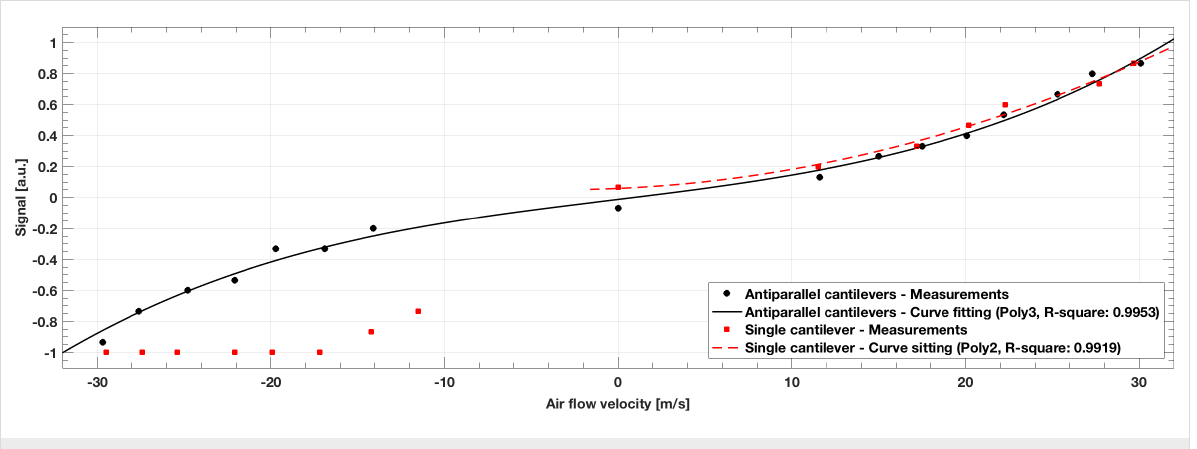
Figure 7: Calibration curve for the single and antiparallel artificial hair sensors. Dots indicate measurement values and the lines represent curve fittings for visual guidance. For the single cantilever, a second-order polynomial fit (R-square: 0.9919) was done for the forward air flow direction. It reached its saturation limit for backward air flow at − 17.2 m s − 1 . The third-order polynomial fit for the antiparallel cantilevers (R-square: 0.9953) proposes an axially symmetrical sensitivity of 40 μ V/(m s − 1 ) for the lower air flow velocity range (between ±10–20 m s − 1 ) and 80 μ V/(m s − 1 ) for a higher air flow velocity range (between ±20–32 m s − 1 ).